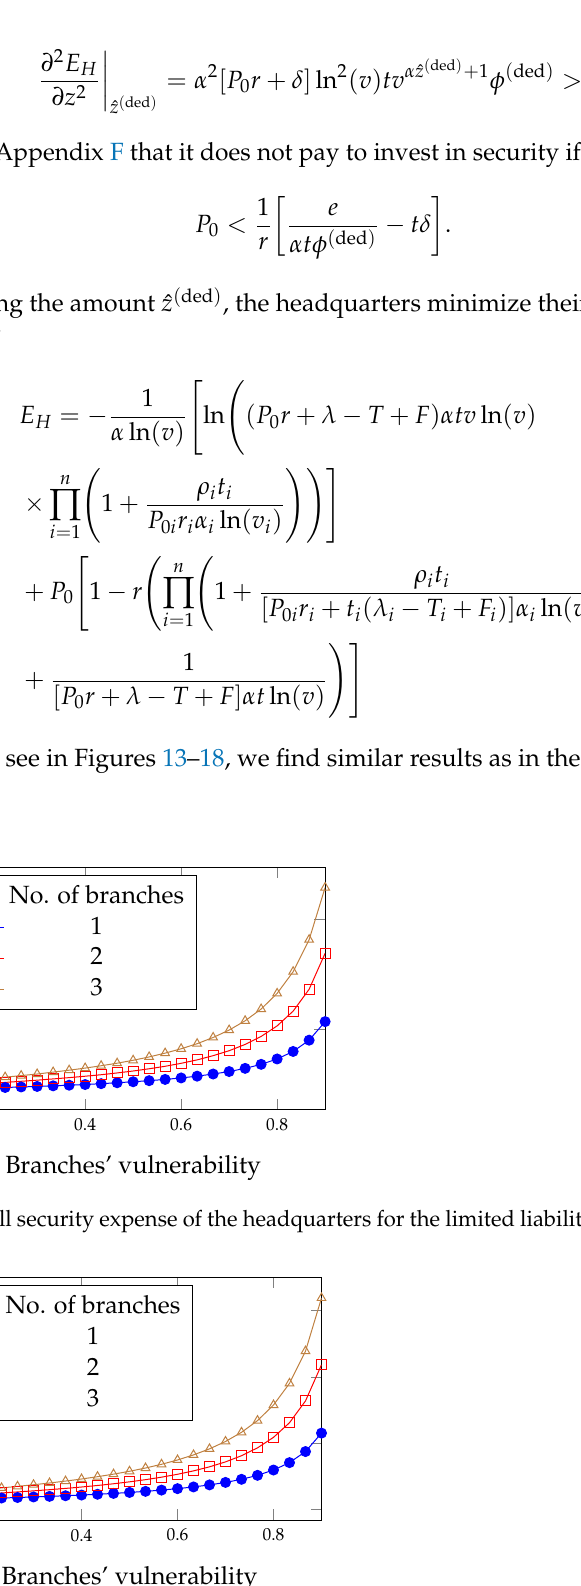
Figure 14. Premium paid by the headquarters in the limited liability with deductibles